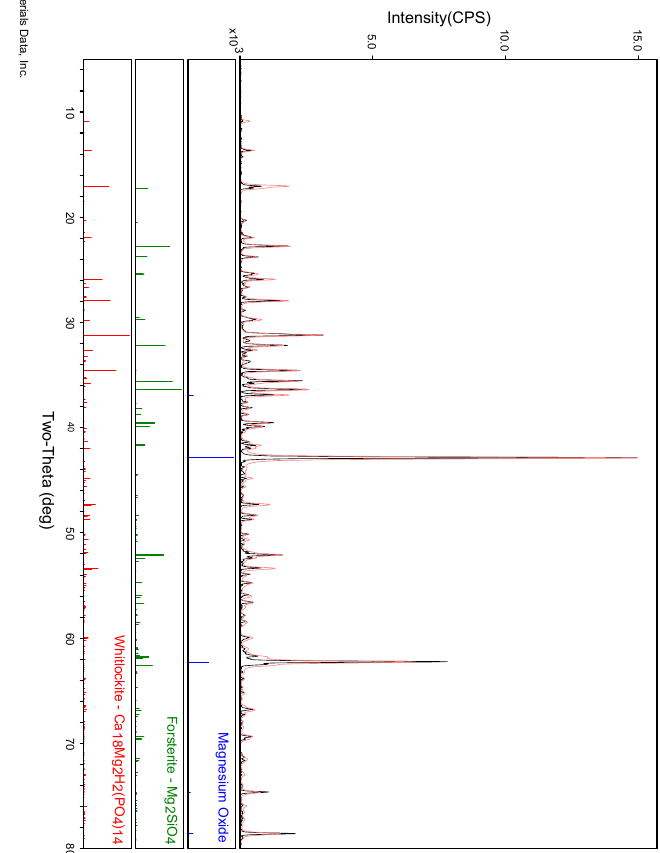
Figure 1. X-ray di ff ractogram of the ceramic Figure 1. X-ray diffractogram of the ceramic material.